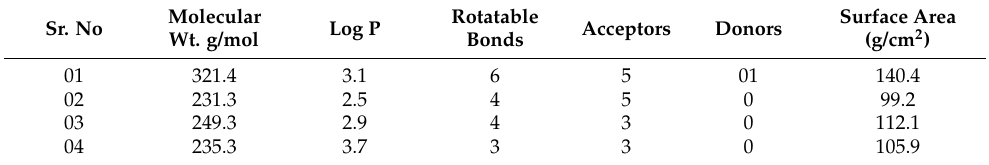
Table 2. Drug-likeness of synthesized compounds.